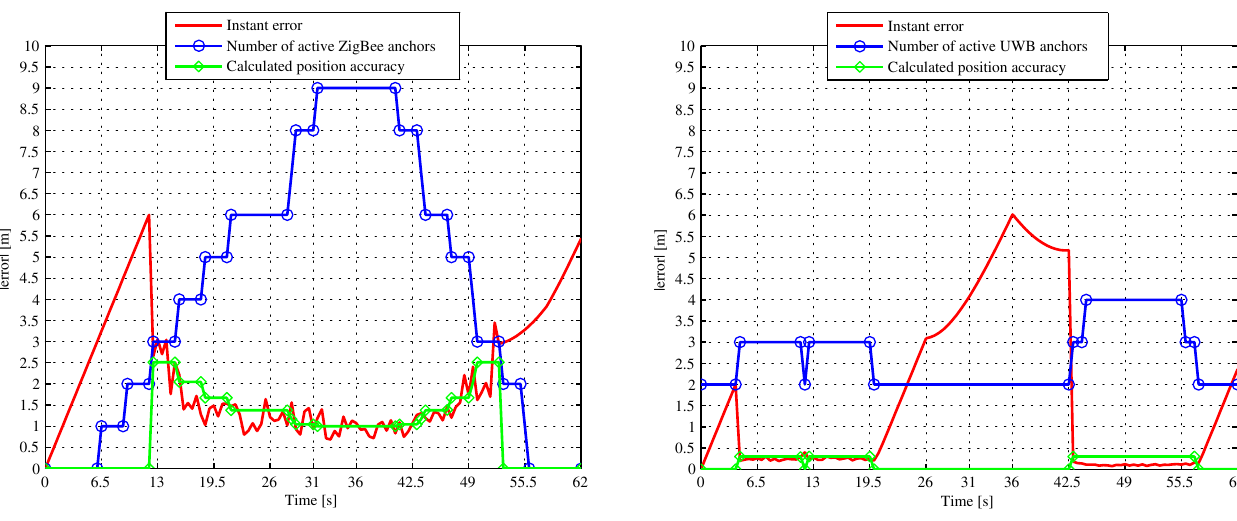
Figure 12. Instant error for the ZigBee and UWB networks when used